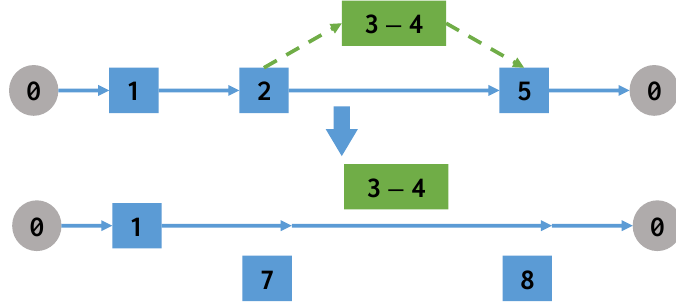
Figure 4. Change the takeoff and landing points of the task.